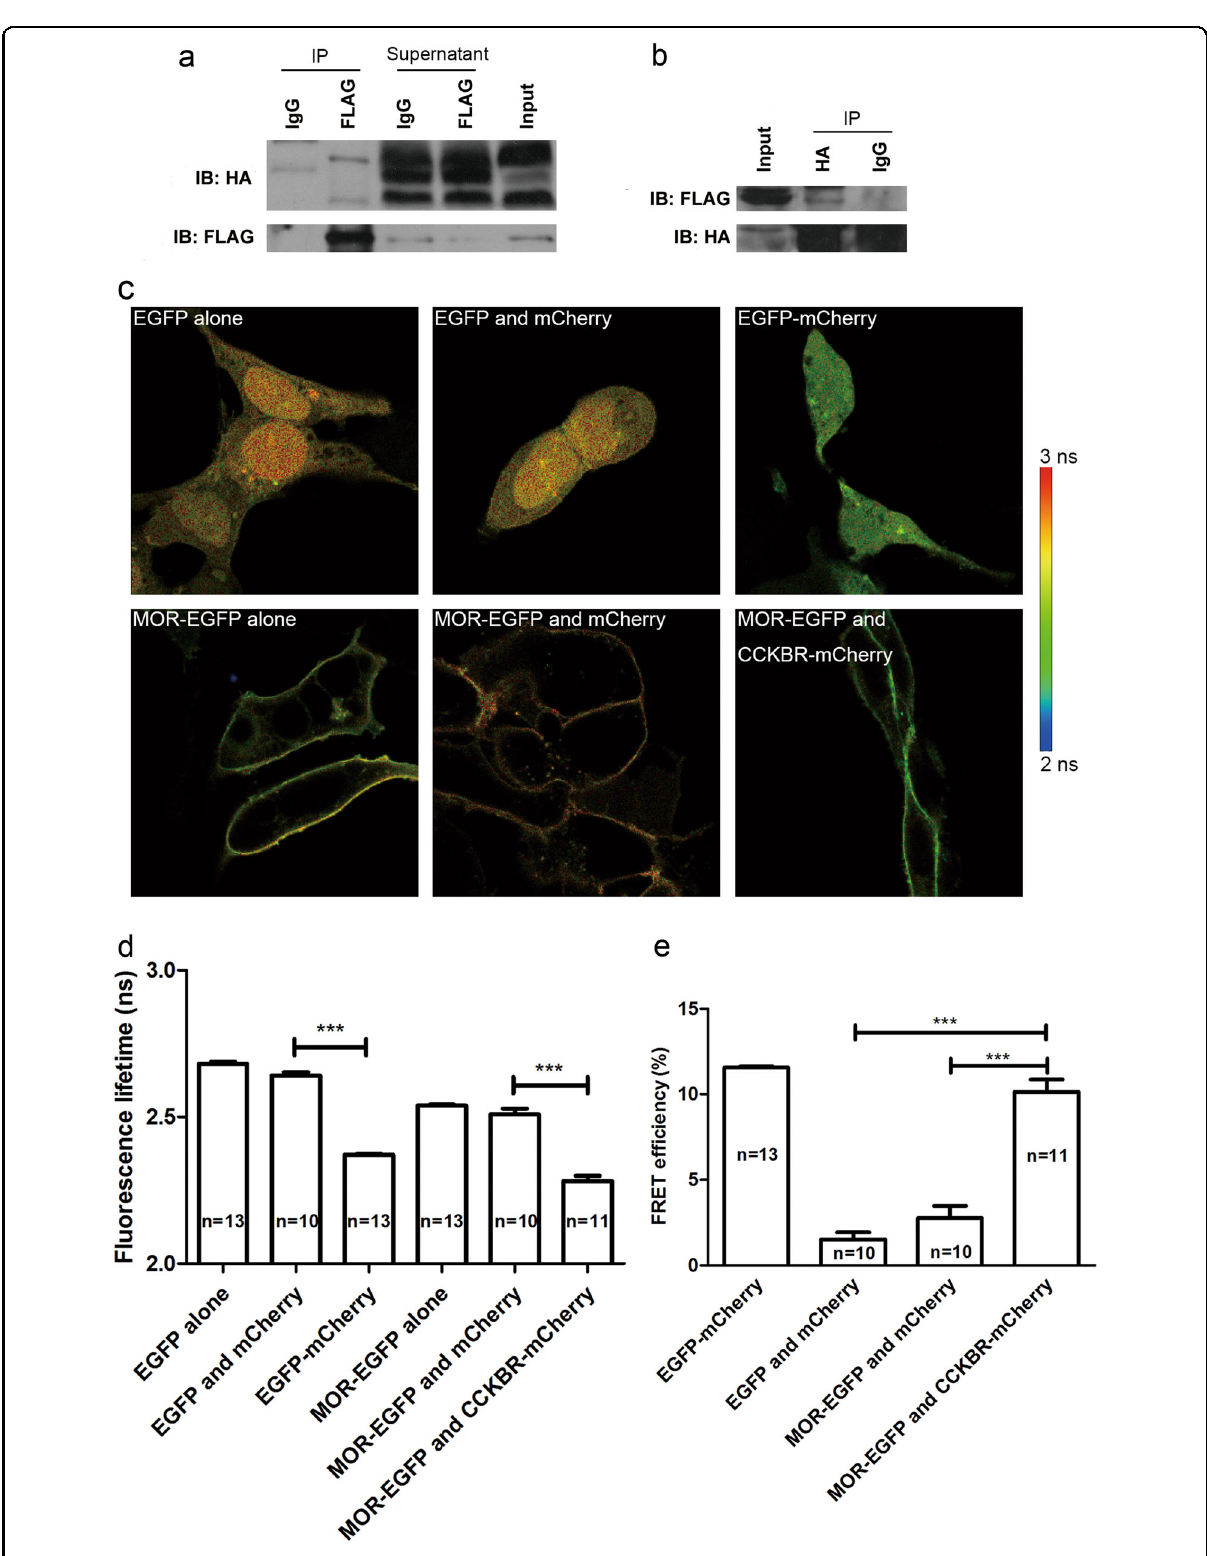
Fig. 2 (See legend on next